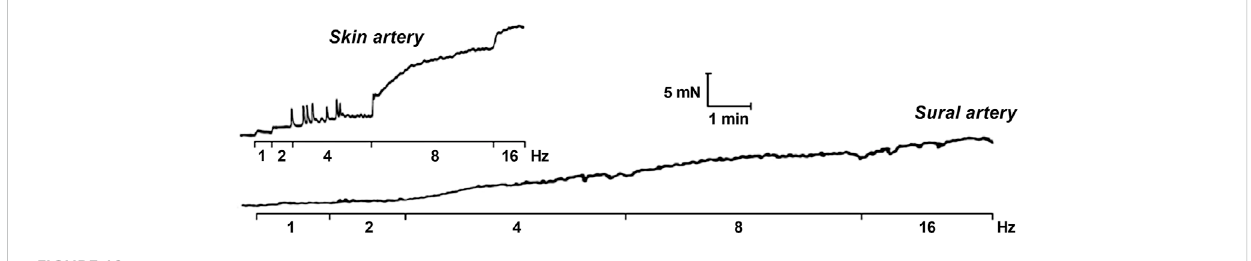
FIGURE 12 Cumulative frequency – response relationships obtained for segments cut from the medial tarsal branch of the saphenous artery (small skin artery, normalized diameter 225 µm) and from the distal (intramuscular) section of the external sural artery (small skeletal muscle artery, normalized diameter 210